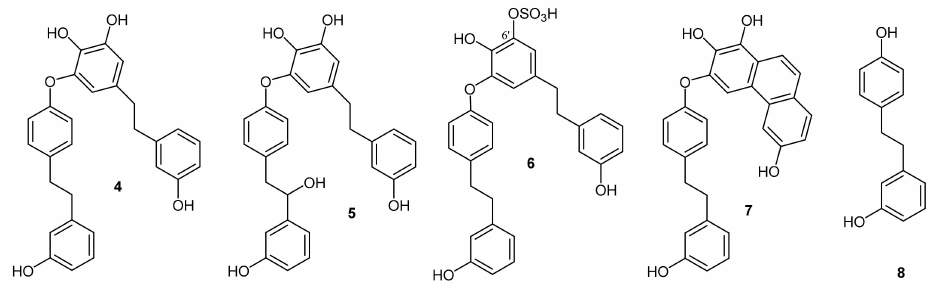
Figure 2. Perrottetin-type bis-bibenzyls added for comparative investigation of cytotoxic activity. First, we analyzed the cytotoxic effects of Compounds 1–8 on acute (HL-60 and U- 937) and chronic (K-562) myeloid leukemia cell lines. Cells were treated for 48 h with increasing concentrations of the selected compounds (1 µ M, 10 µ M, 25 µ M, 50 µ M, and 100 µ M) and cell viability was evaluated using an MTS [3-(4,5-dimethylthiazol-2-yl)-5- (3-carboxymethoxyphenyl)-2-(4-sulfophenyl)-2H-tetrazolium)] assay (Figures 3–5). As presented in Figure 3, with IC 50 values of 14.2 µ M and 39.2 µ M, Compounds 1 and 7 had the highest cytotoxicity on HL-60 cells, respectively. Compound 4 showed a weak cytotoxic effect (IC 50 = 68.5 µ M), while the other tested compounds, including Compounds 2 and 3 for the first time isolated from P. endiviifolia , showed non-cytotoxicity toward HL-60 (IC 50 values > 100 µ M) (Figure 3). We observed a high standard error of the mean (SEM) for the cytotoxic activity of Compound 1 (at a concentration of 25 µ M) and Compounds 2 and 4 (at concentrations 25 µ M and 50 µ M) (Figure 3). We speculate that HL-60 cellular heterogeneity [20] (reviewed in the use of the HL-60 cell line to measure the opsonic capacity of pneumococcal antibodies) contributes to the observed differences in the sensitivity to the tested compounds.